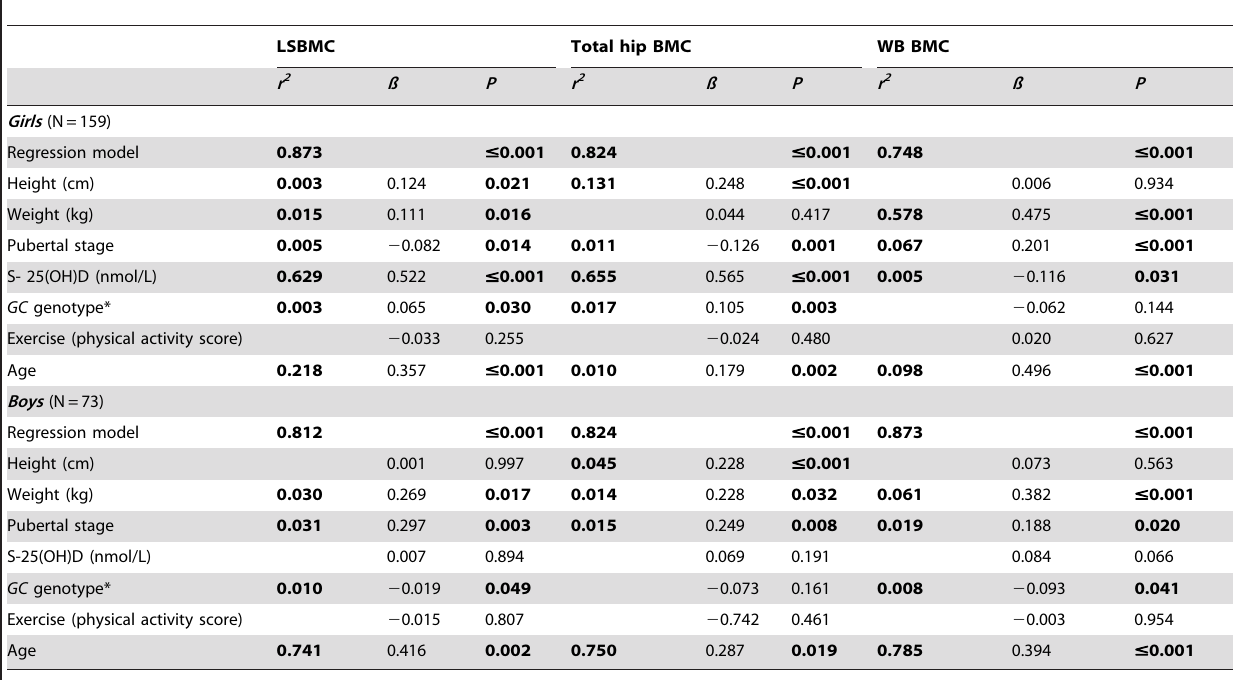
Table 5. Linear regression analysis for determinants of bone mineral content in groups defined by